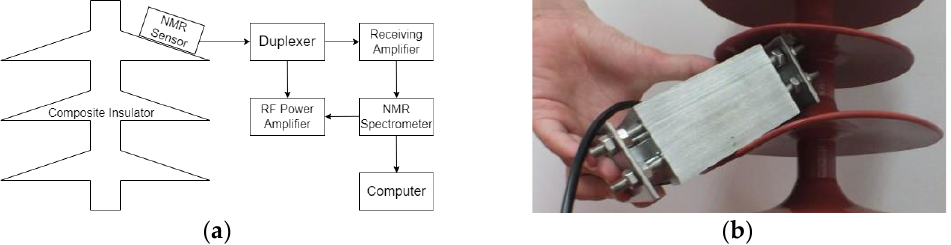
Figure 12. ( a ) Diagram of the sensor measurement principle; ( b ) diagram of the sensor measurement method.